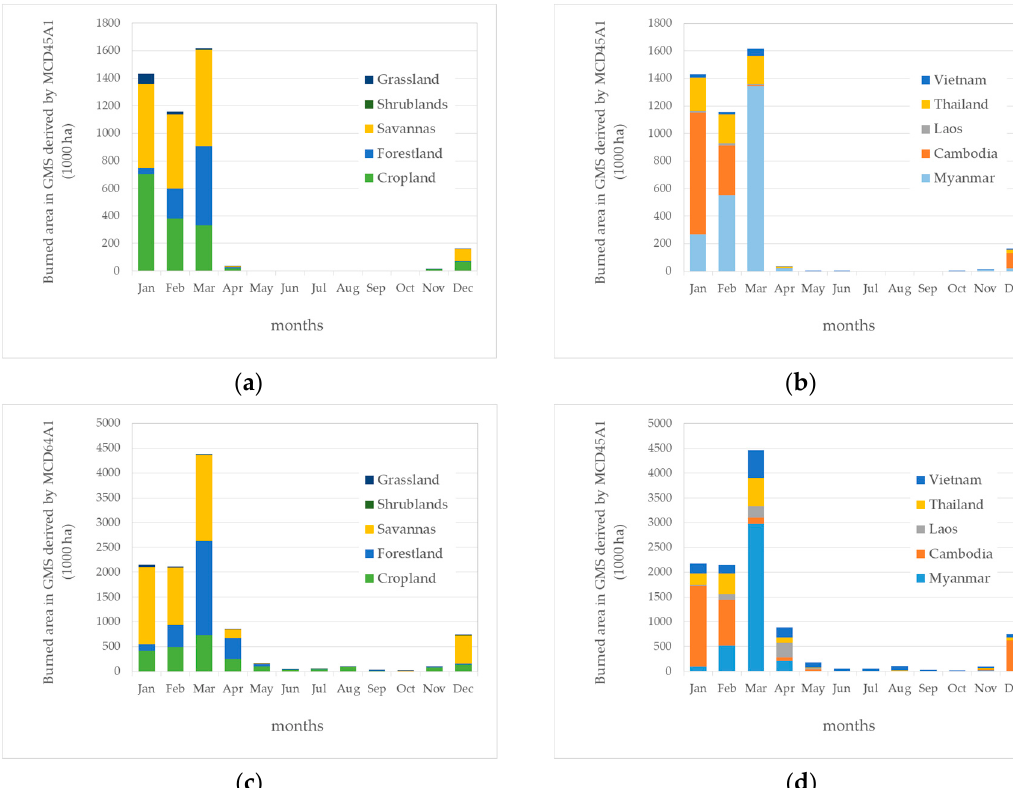
Figure 4. Monthly temporal distribution of the total burnt area from the biomass open burning classified by country and vegetation fire derived by the MCD45A1 (( a ) and ( b )) and the MCD64A1 (( c ) and ( d )) in 2015.